Question: From the figure, is the trend upward or downward?
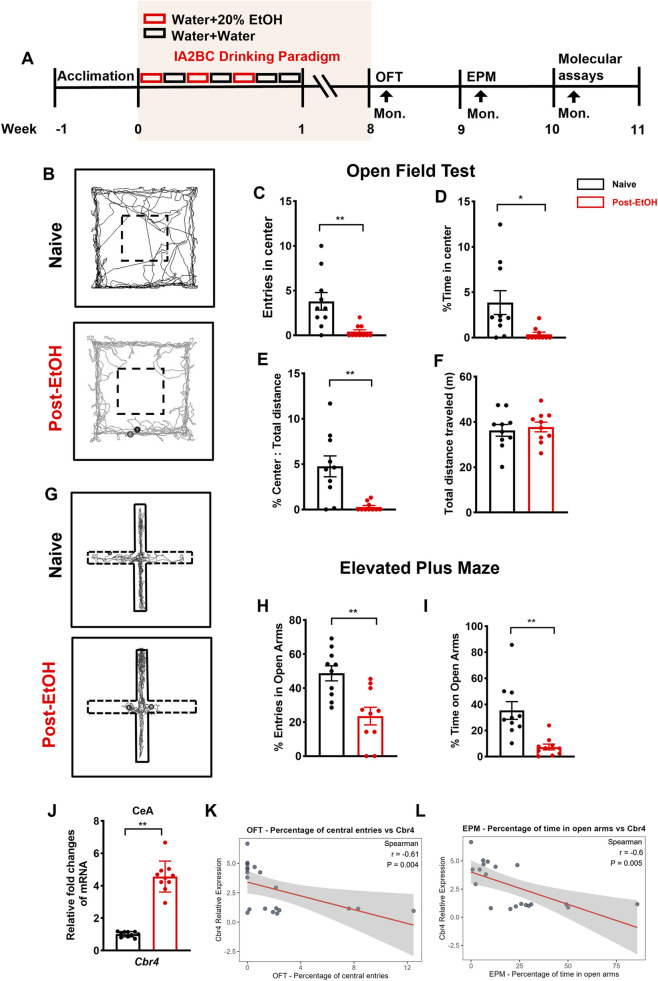
Answer: increasing